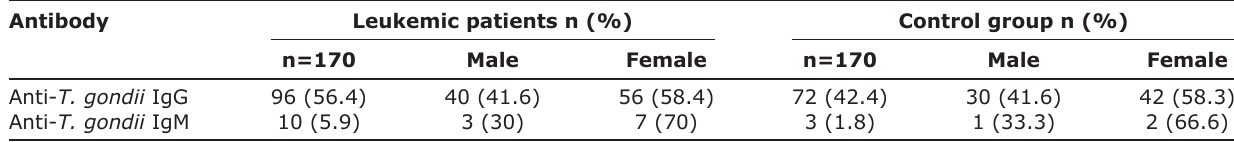
Table-2: The result of serosurvey for T. gondii antibodies of leukemic patients and the control group.